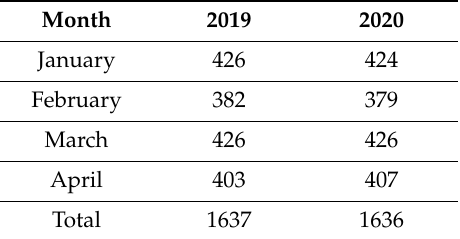
Table 1. Number of Sentinel-5P scenes used per month and year.